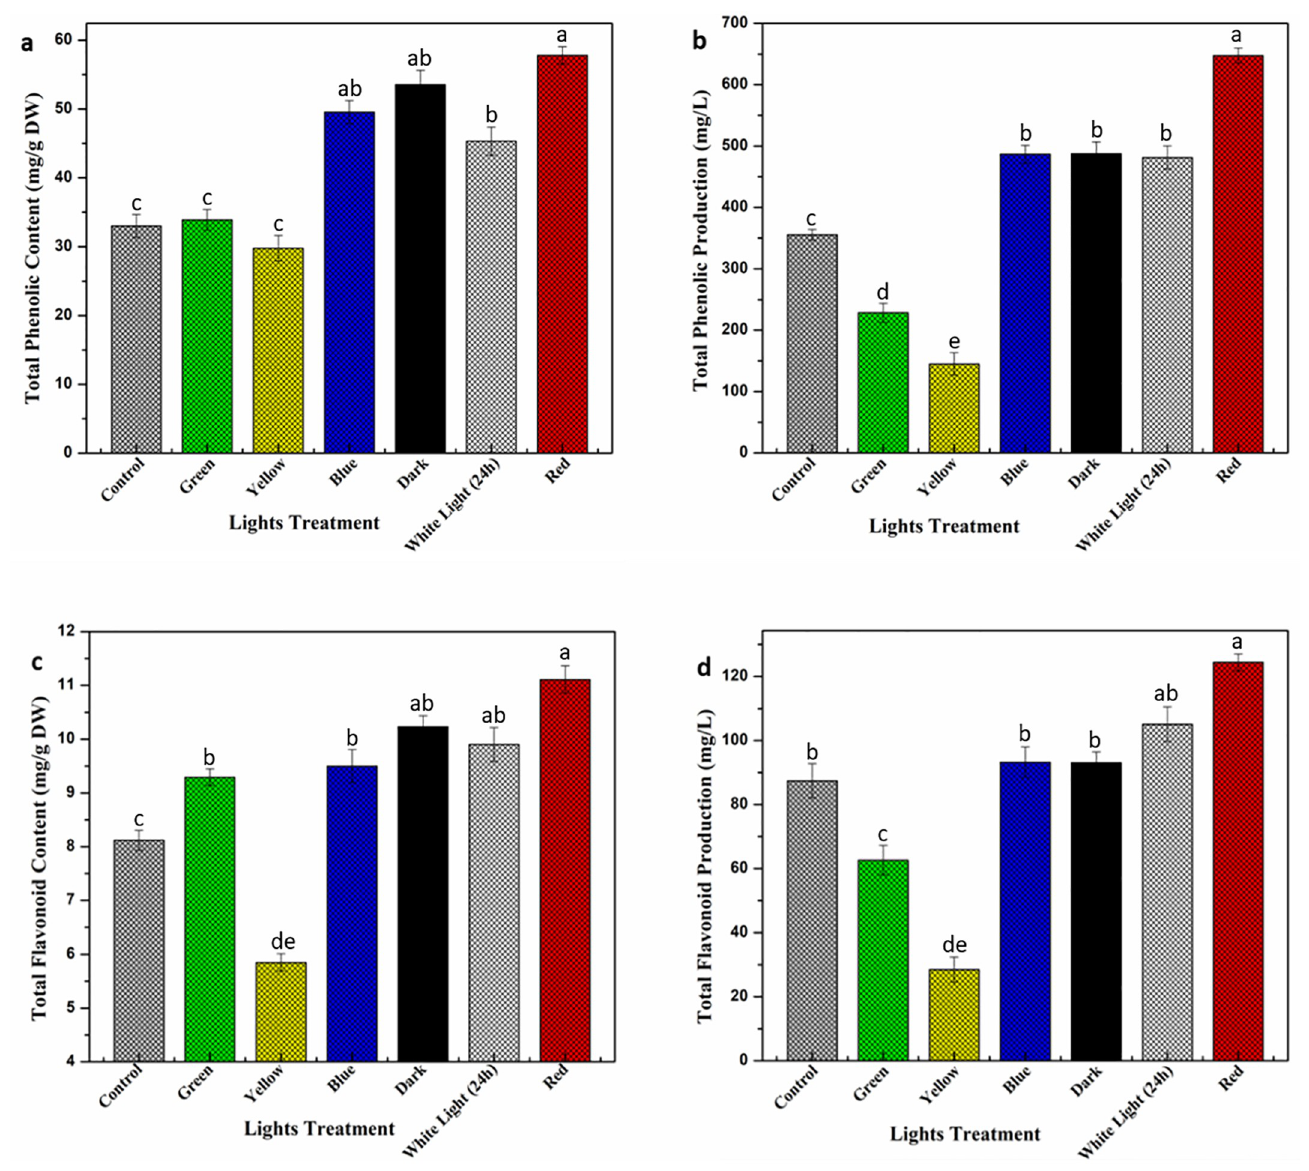
Fig 3. Differential effect of lights on a) TPC (mg/g DW): b) TPP (mg/L): c) TFC (mg/g DW): d) TFP (mg/L) accumulation in callus cultures. Error bar represents means deviation of